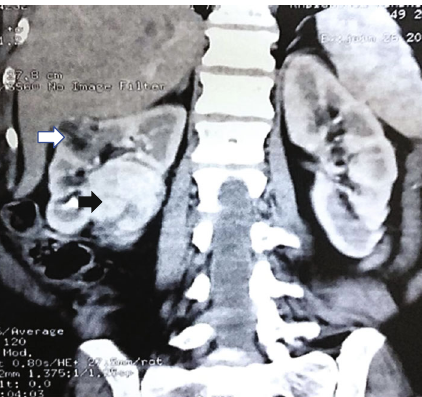
Figure 1: Computerized tomography urography scan showing two tumors in the midportion of the right kidney with distinct radiologic appearances: the external mass (white arrow) is a fat- containing tumor suggesting AML. The internal tumor (black arrow) is solid demonstrating a heterogeneous enhancement pattern.